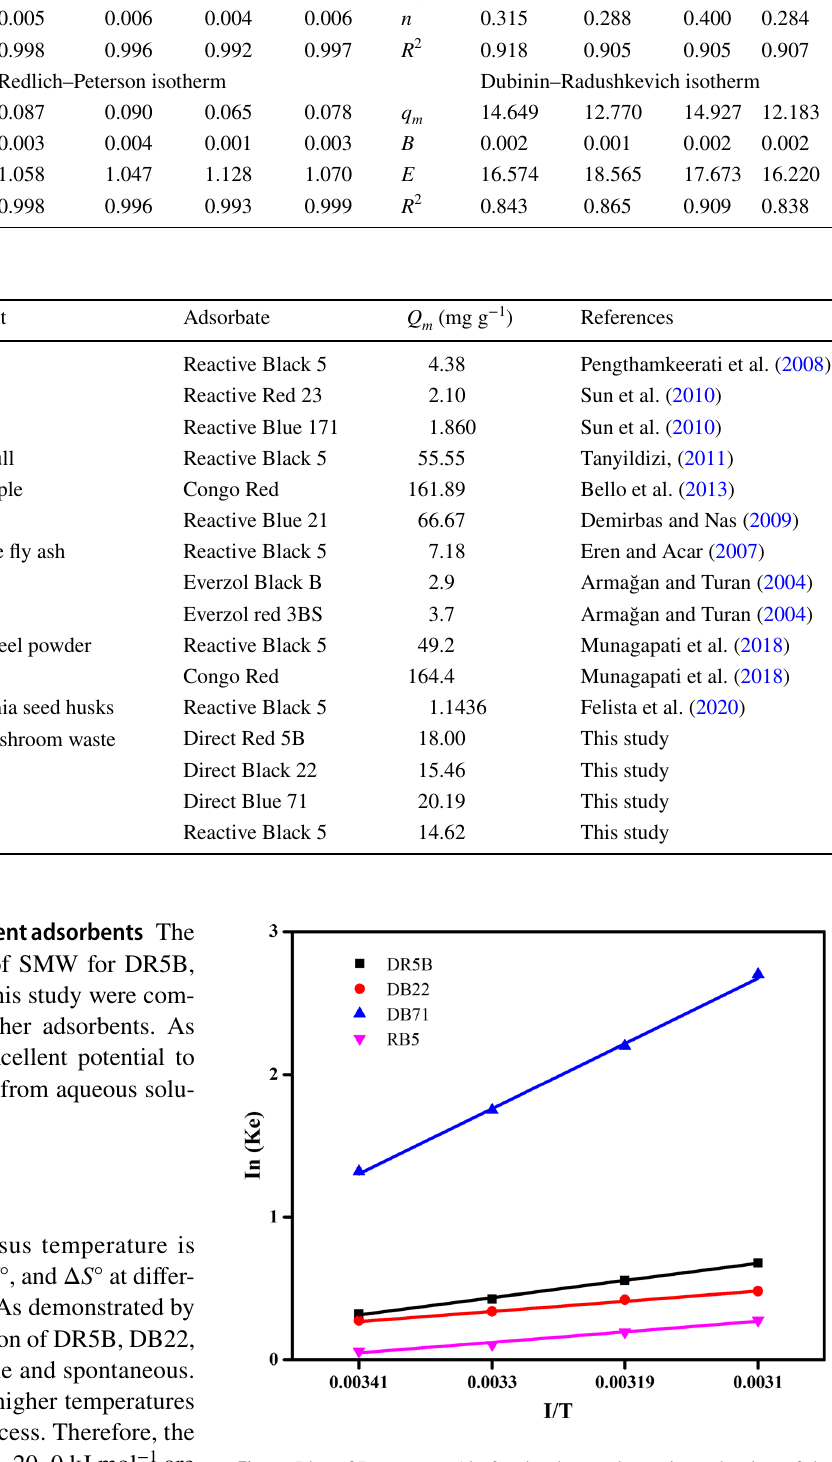
Table 1 Isotherm parameters for the adsorption of DR5B, DB22, DB71, and RB5 onto SMW